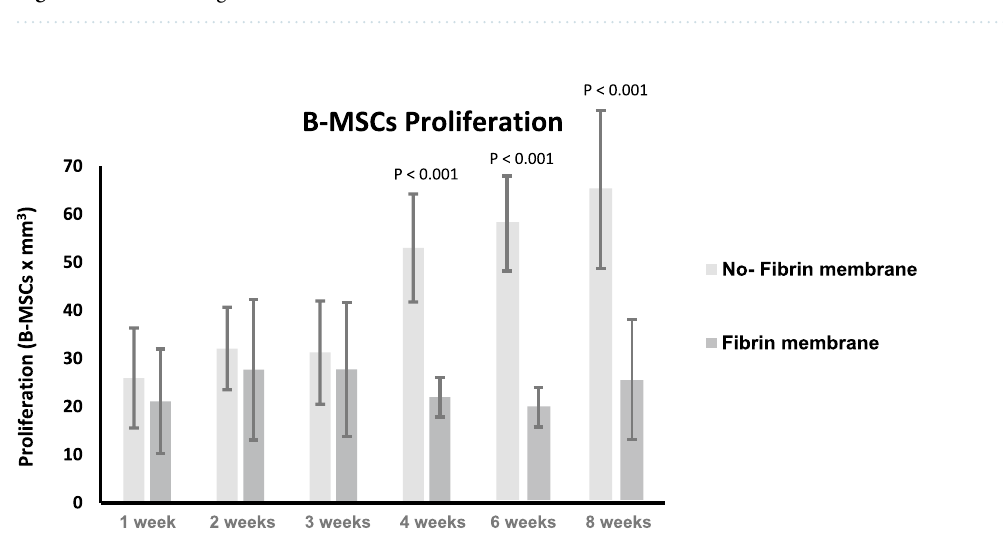
Figure 4. B-MSCs proliferation within the